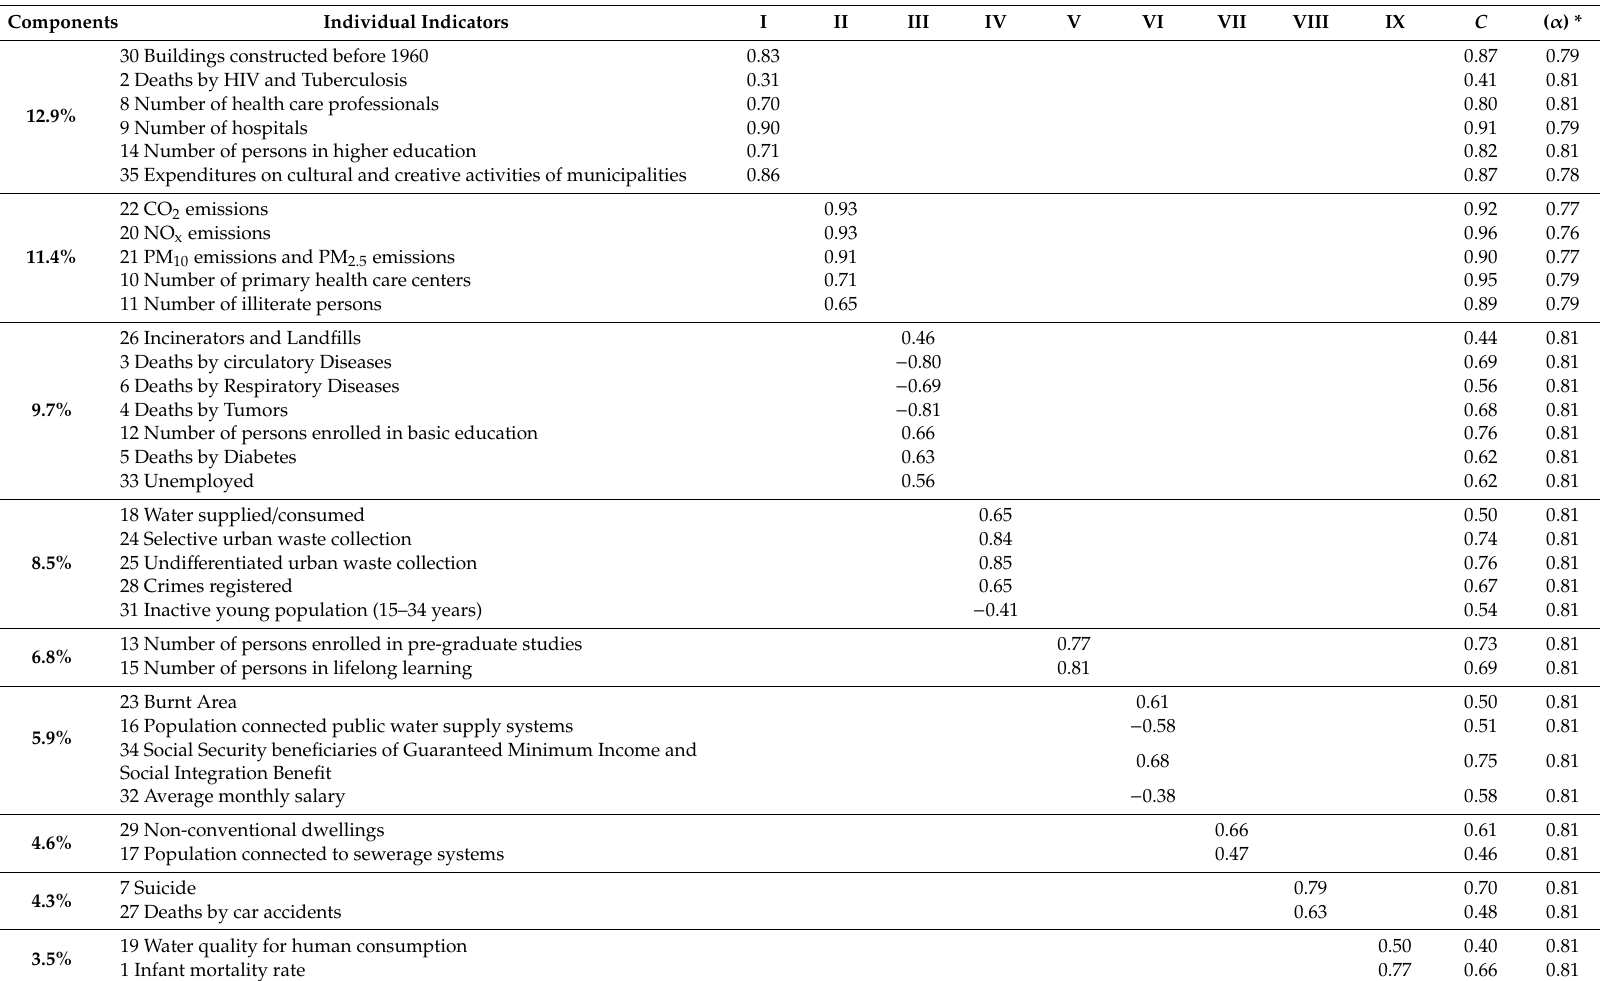
Table 2. Factor analysis for SEHVI